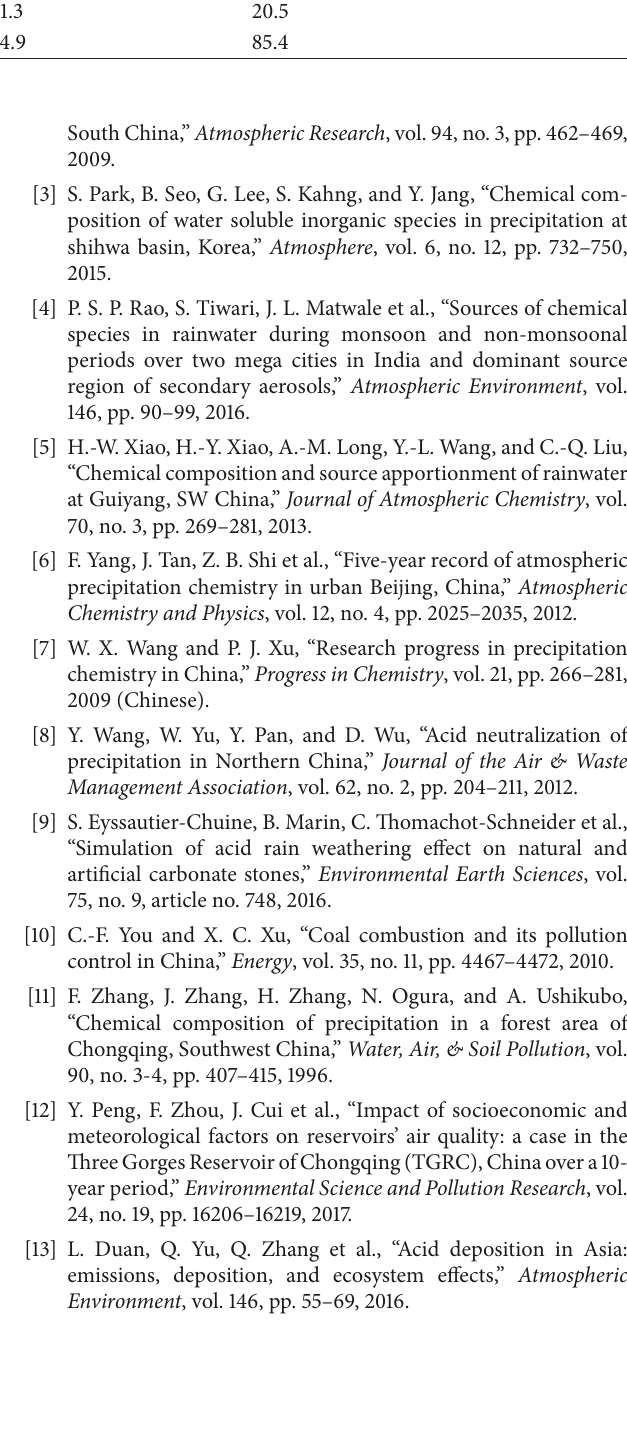
Table S1: monthly data of ionic concentration of precipitation, mass concentration of particulate matter, and meteorological factors in Wanzhou. (Supplementary